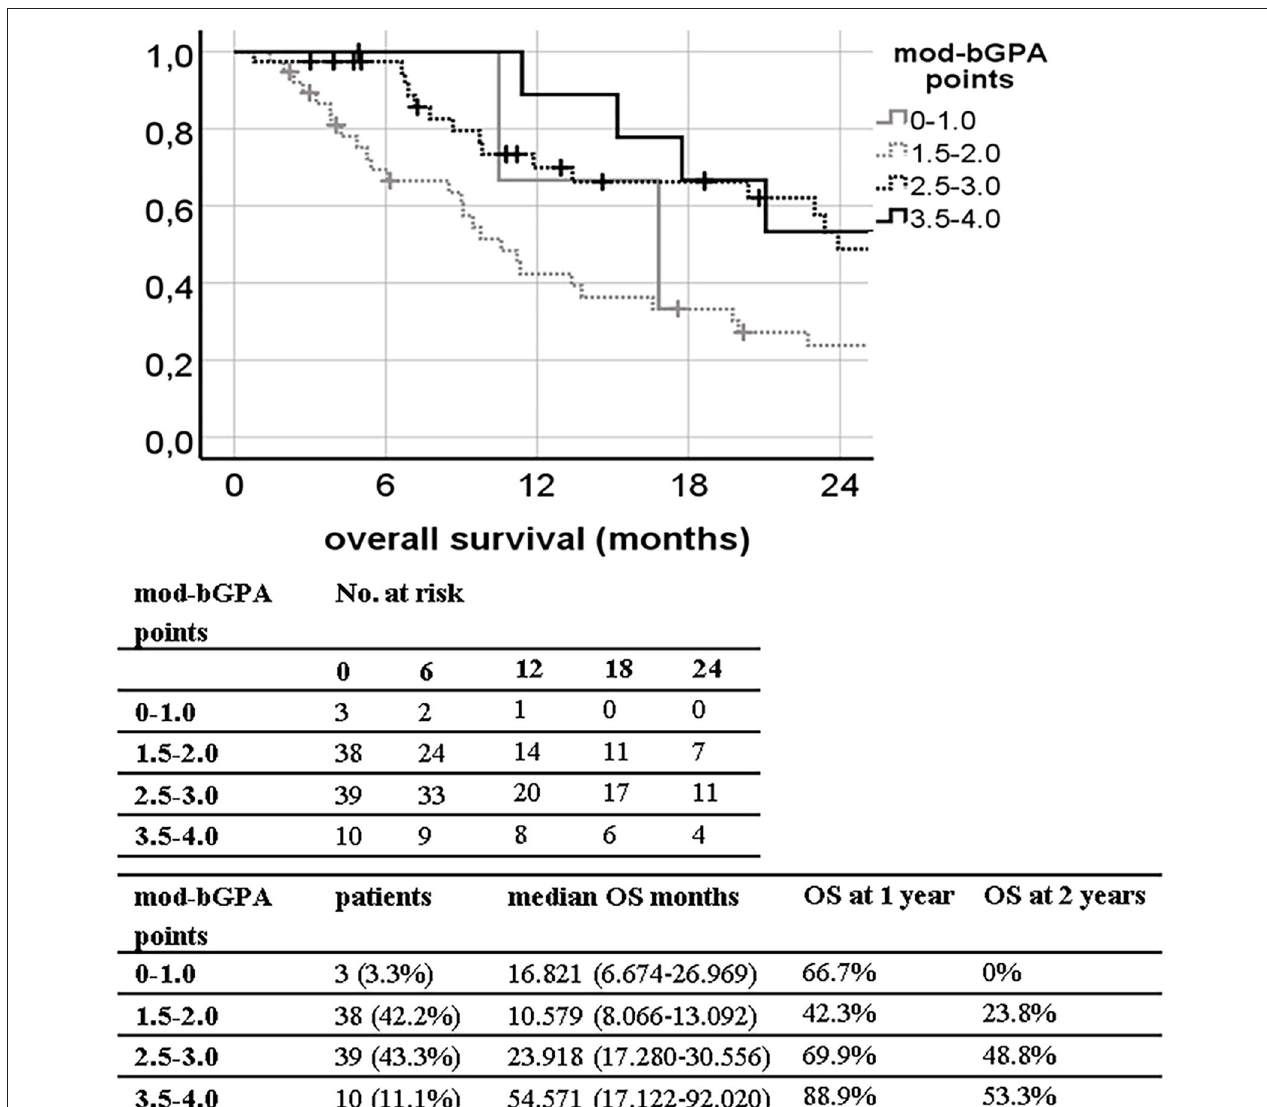
FIGURE 2 | Kaplan–Meier curves for overall survival (OS) divided by the modified breast graded prognostic assessment (mod-bGPA) in our patient population (log-rank p = 0.003; concordance index 0.662; 95% CI, 0.547–0.777; p = 0.010) with median OS and 1- and 2-year OS estimates.